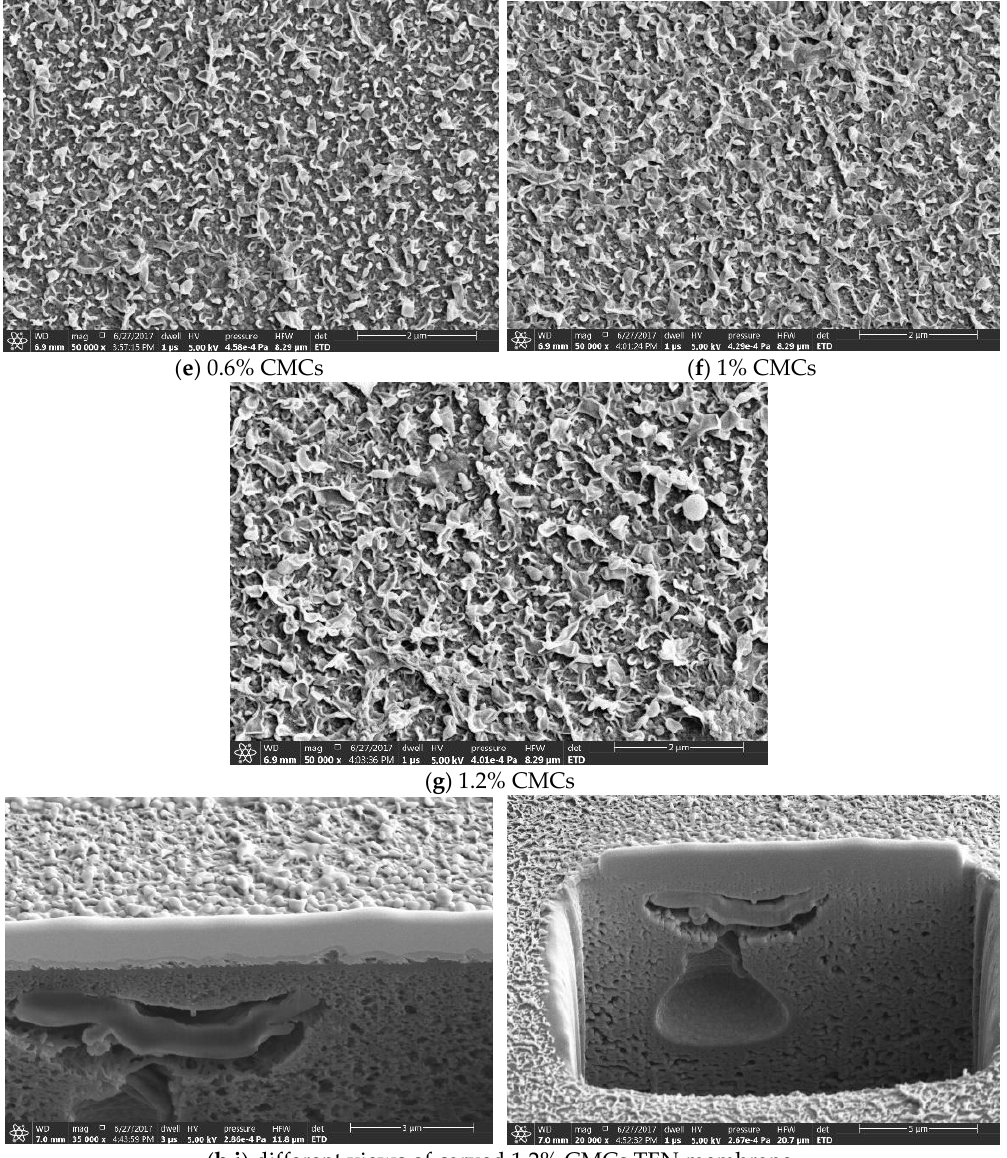
Figure 2. SEM images for TFN membranes filled with different ratios of CMC, ( a ) 0%, ( b ) 0.1%, ( c ) 0.2%, ( d ) 0.3%, ( e ) 0.6%, ( f ) 1%, ( g ) 1.2%, and ( h , i ) different views of carved 1.2% CMC membrane.